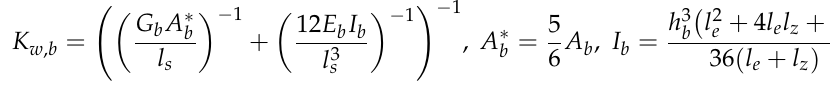
Figure 10. Cross-section of the stress cone in the transversal direction. K is then equal to: The shear stiffness , w b